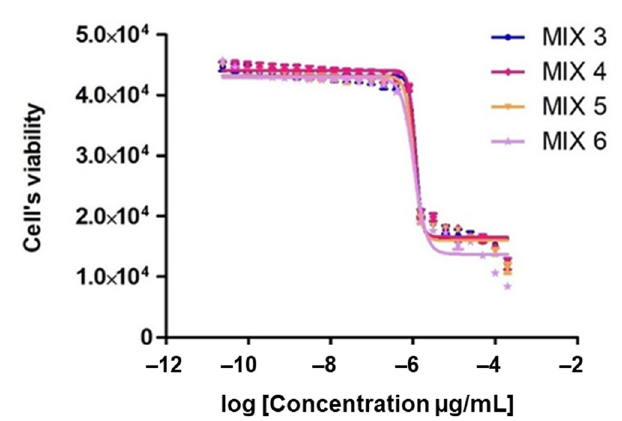
Figure 3. Tests of combinations of EO constituents against T. brucei . The different mixes are described in Table 3 and the curves are colored according to the following scheme: Mix 3 (blue curve), Mix 4 (red curve), Mix 5 (orange curve), and Mix 6 (purple curve). Each EC 50 value represents the mean of four independent experiments with standard errors.